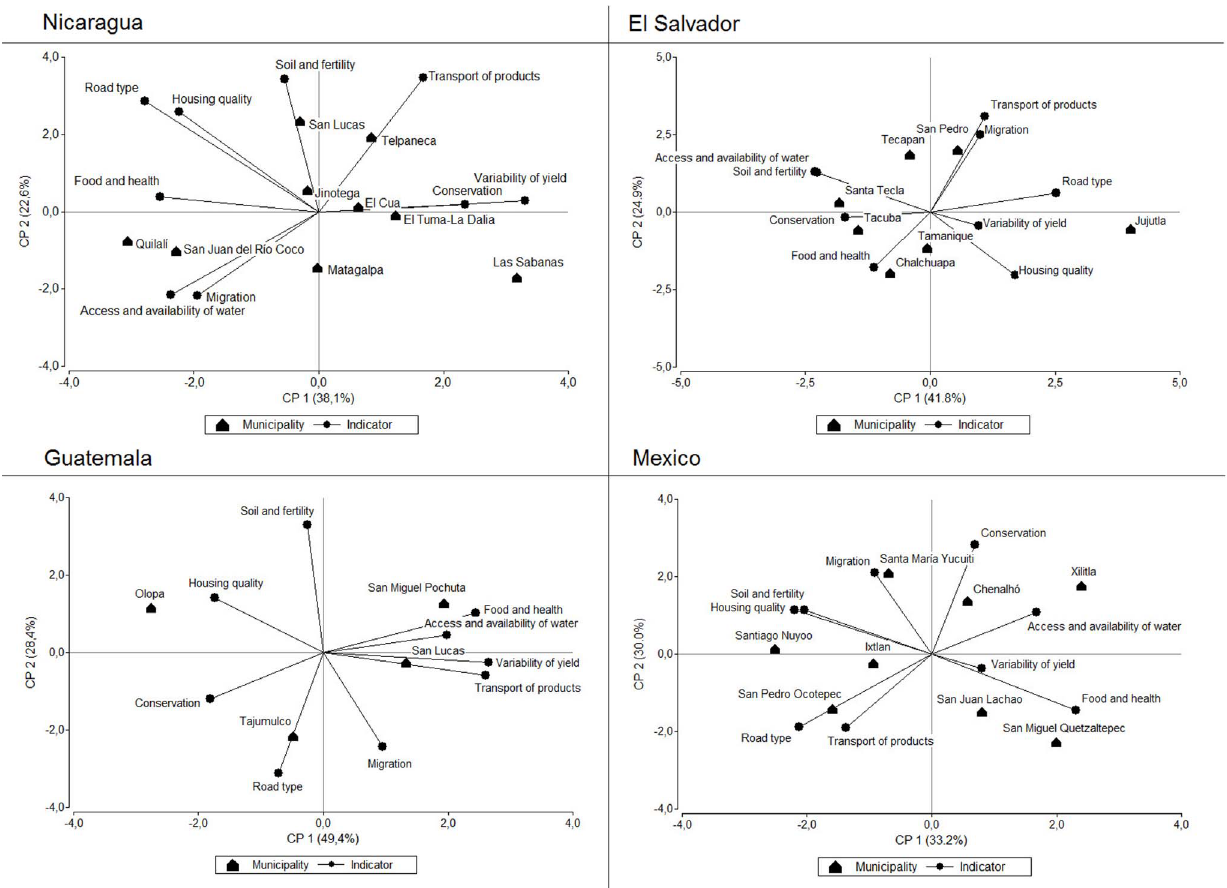
Table 4. Distribution of families per level adaptive capacity between countries.